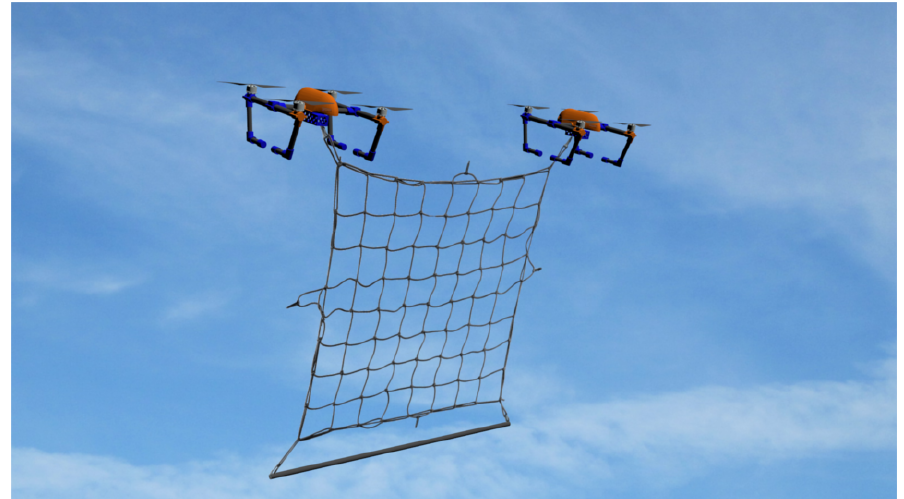
Figure 1. Model of the UAV system carrying a